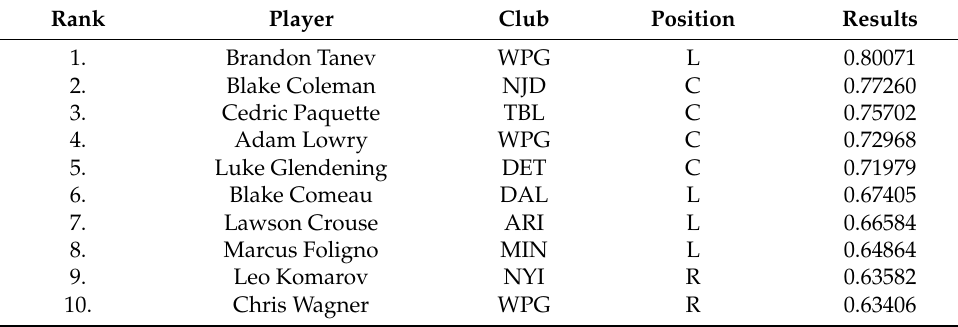
Table 8. Ten best players as evaluated by the SVP–TOPSIS